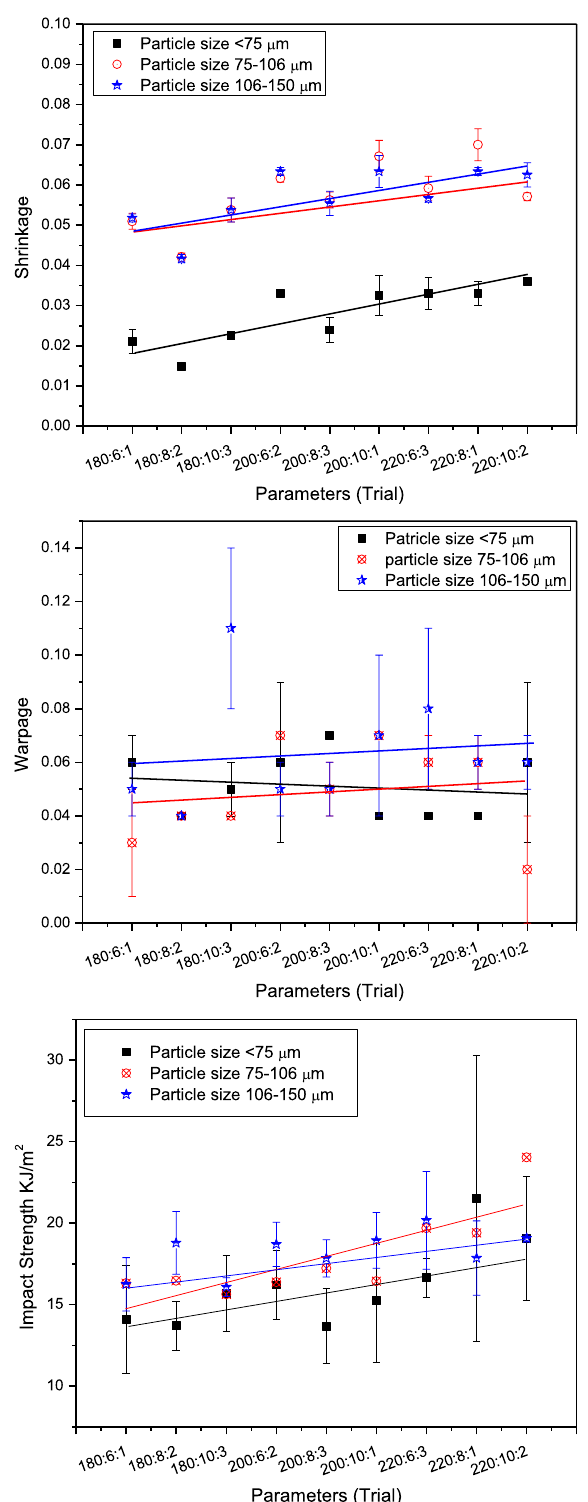
Fig. 1 Correlation effect between shrinkage, warpage and impact strength and process parameters (trial number) for composites containing various clay particle